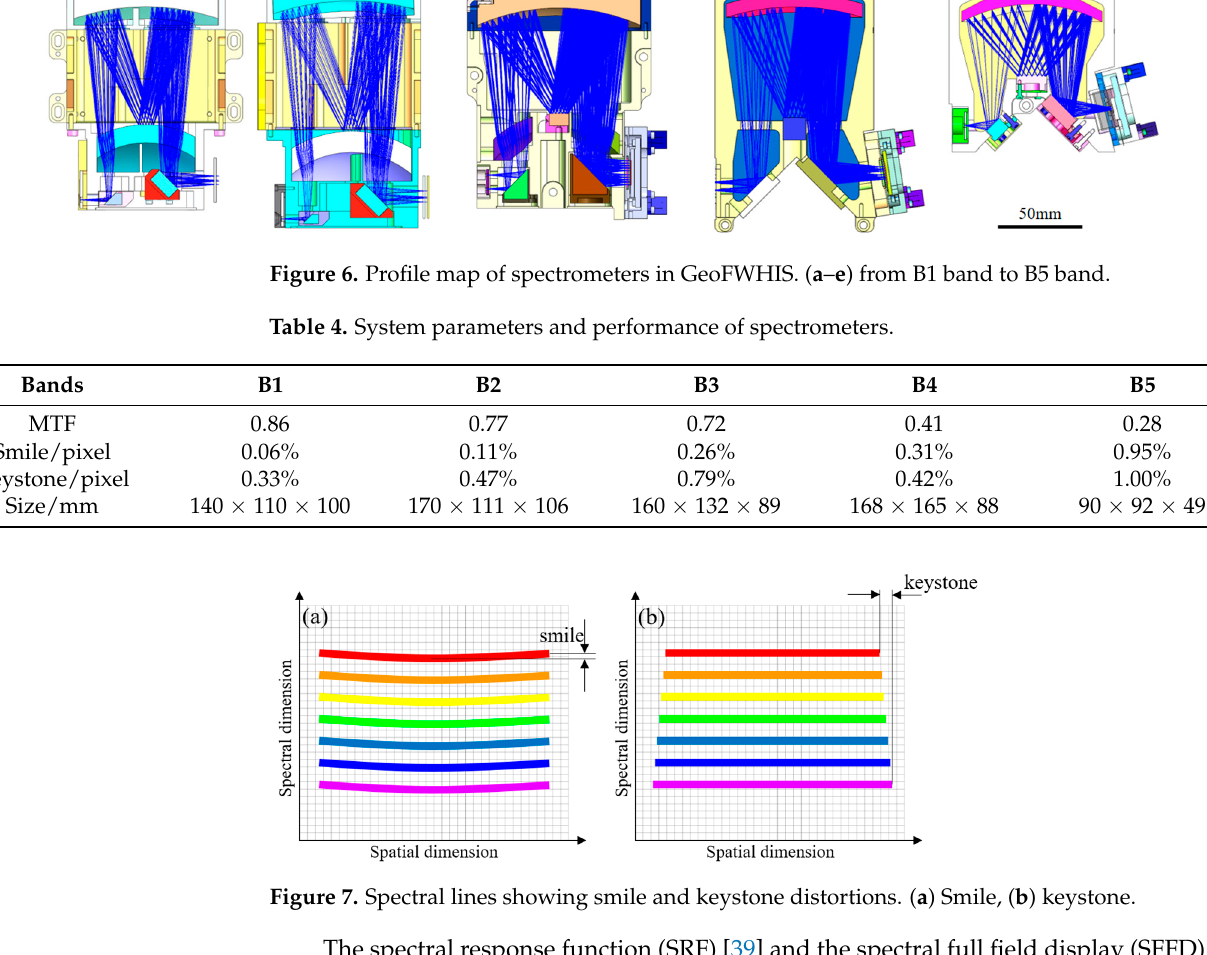
Figure 7. Spectral lines showing smile and keystone distortions. ( a ) Smile, ( b ) keystone. The spectral response function (SRF) [39] and the spectral full field display (SFFD) [51] of B1 and B3 bands are given in Figure 8. SRF describes the response of the spectrom- eter to the monochromatic light with unit intensity, and it is affected by the spectrometer optical system and the detector sampling. We consider that the slit is along the x -axis, and then the spectral direction is along the y -axis. If the detector sampling is not taken into account, SRF of the optical system—i.e., SRF opt —can be computed as the convolution of